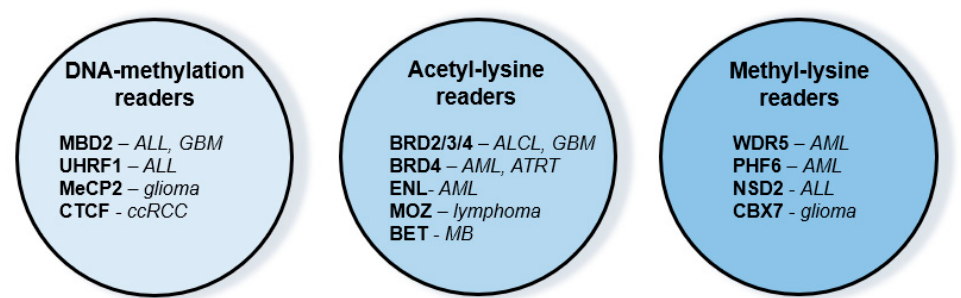
Figure 2. Reader molecules as novel therapeutic targets in pediatric malignancies (see references in the text). Abbreviations of diseases: ALCL: anaplastic large cell lymphoma, ALL: acute lymphoblastic leukemia, AML: acute myeloid leukemia, ATRT: atypical teratoid rhabdoid tumor, ccRCC: clear cell renal cell carcinoma, GBM: glioblastoma multiforme, MB: medulloblastoma.